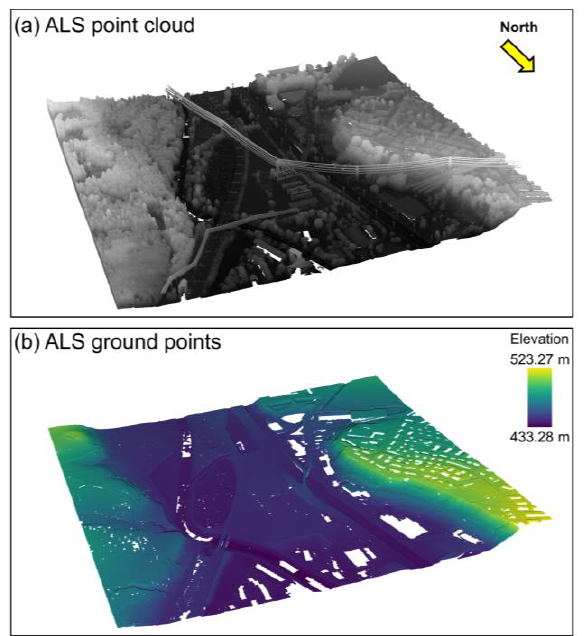
Figure 5 Vo-SmoG result ( VS Ground = 0.5 m) for the ALS point cloud.